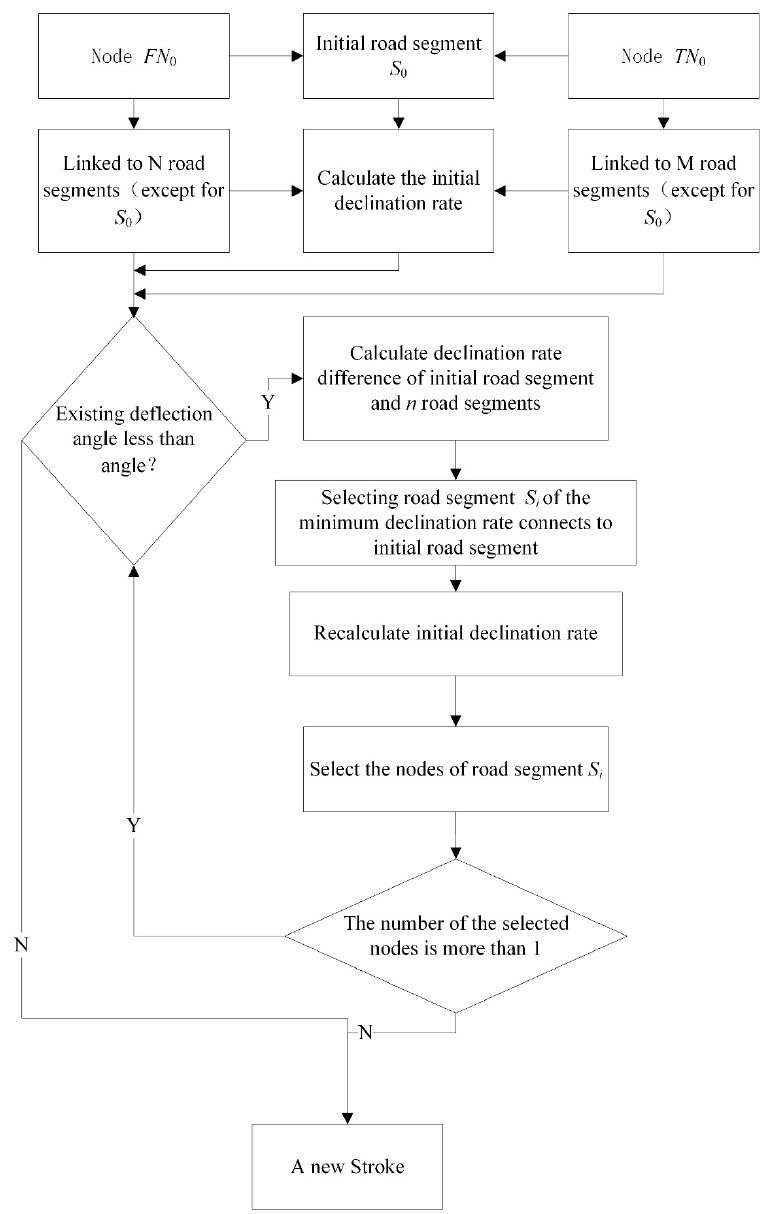
Figure 3. Calculation flowchart for stroke connection rules.